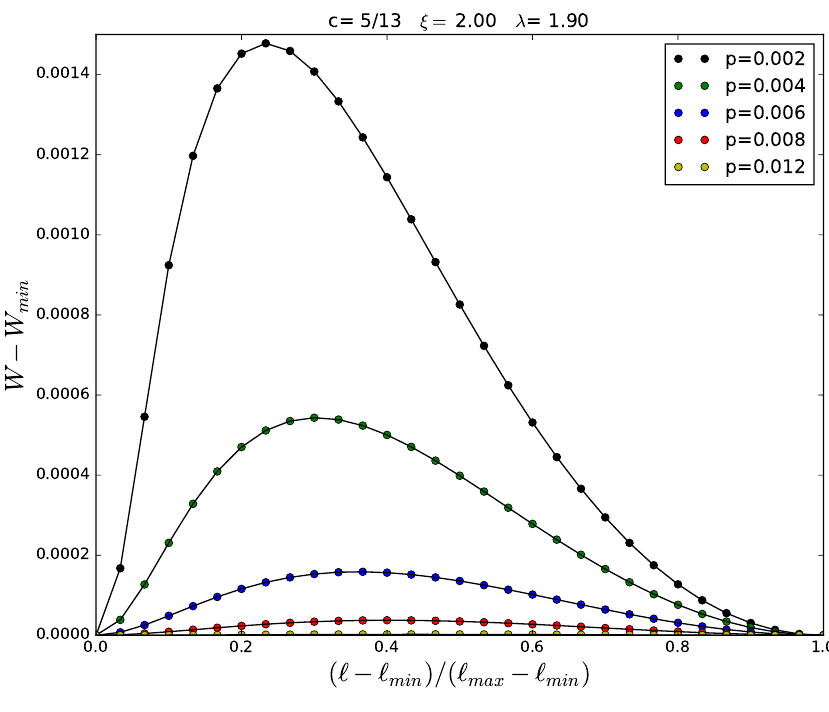
Figure 20: Energy barriers of Peierls-Nabarro for different pressures. There is a pinned-to-unpinned Aubry transition when the barrier vanishes. Here λ = 1.90, ξ =